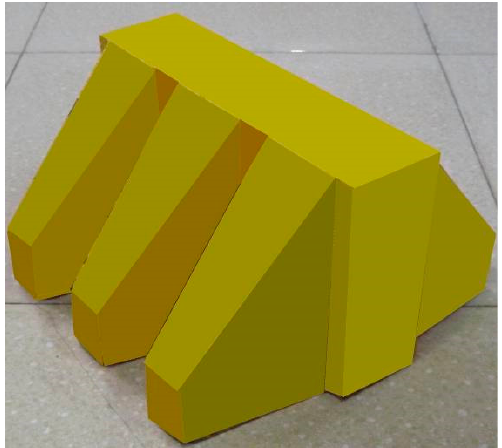
Figure 7. A single block model of a spur dike with tooth-shaped structures.